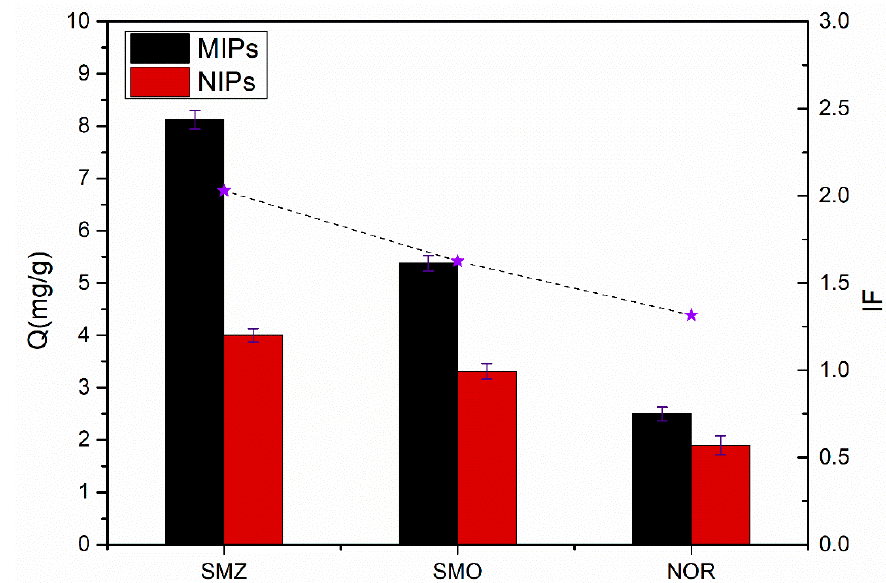
Figure 10. The binding amounts of MIPs and NIPs for SMZ, sulfamethoxazole (SMO) and norfloxacin (NOR) (10 mg of MIPs/NIPs in 5 mL solution containing 0.3 mmol·L − 1 of SMZ, SMO or NOR for 5 h). Each Q value takes the average of three measurements, and the error bars represent the SD.